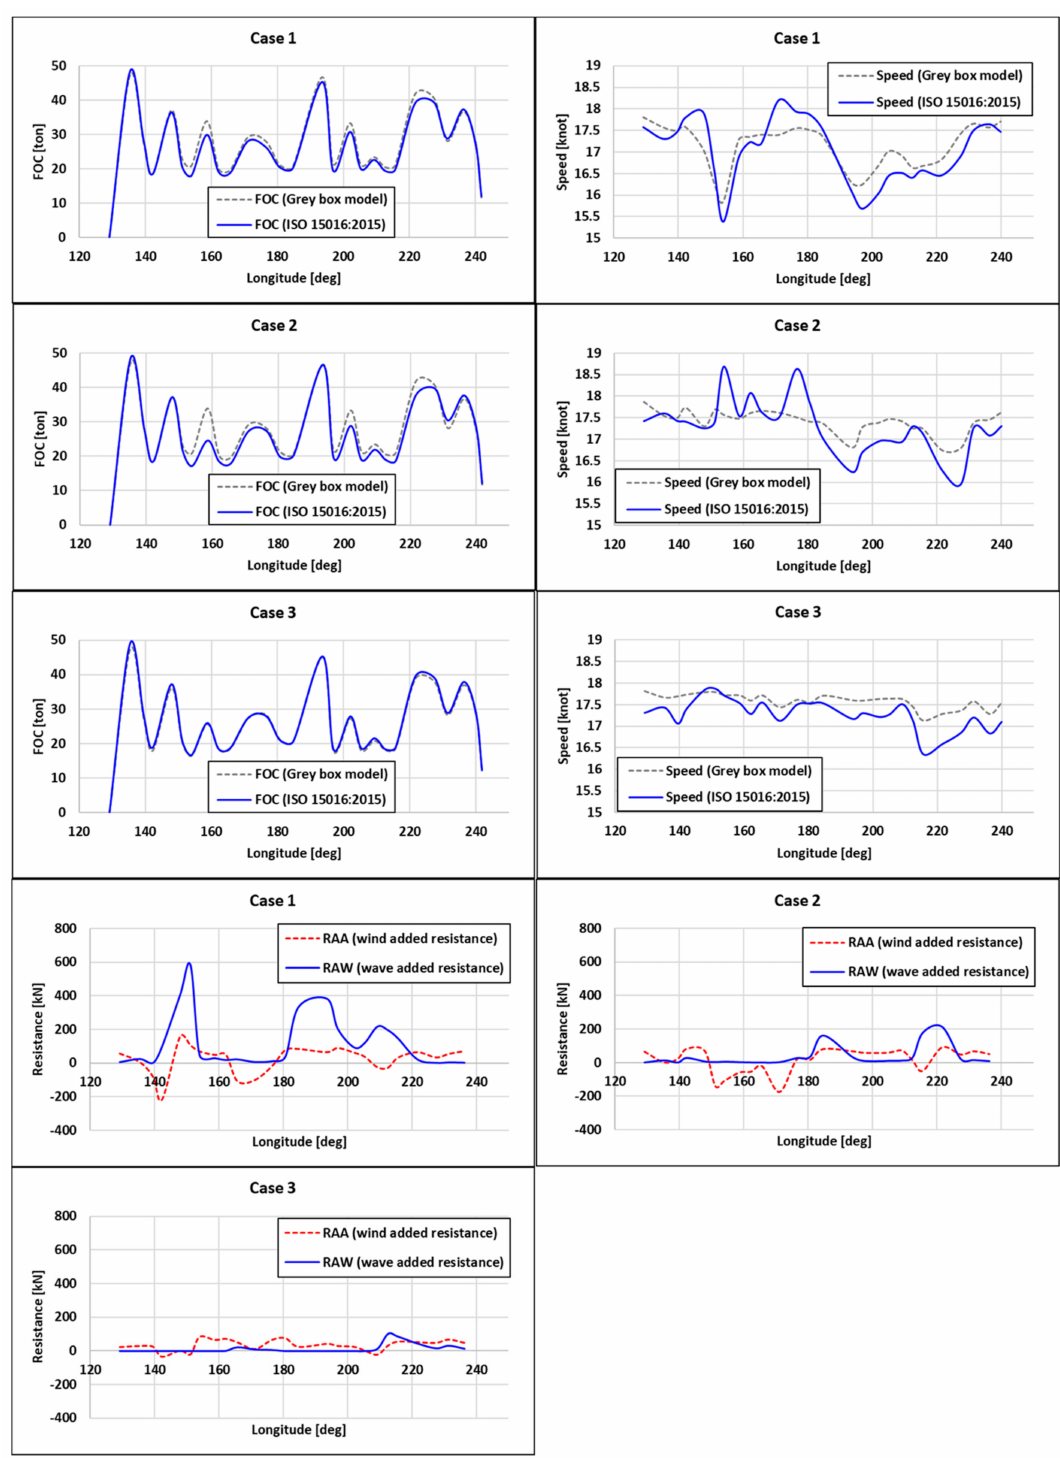
Figure 11. FOC, speed, and additional resistance graphs of Cases 1, 2, and